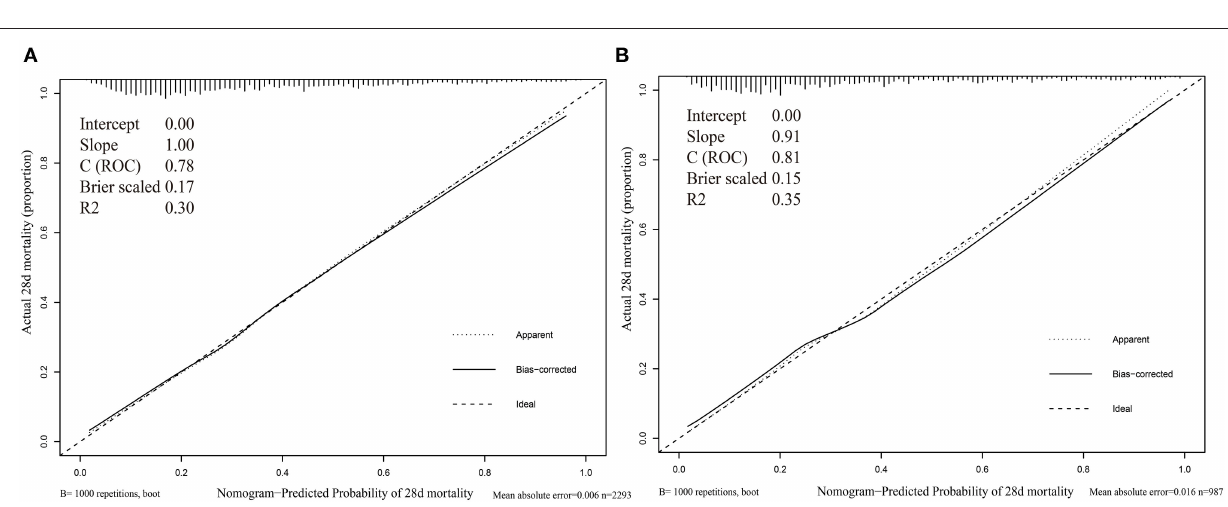
FIGURE 2 | The ROC curve of the nomogram, RF model, SVM model, SOFA, LODS, SAPS II and SIC. (A) Training set; (B) Validation set. The variables entered in nomogram, RF model and SVM model are the same.